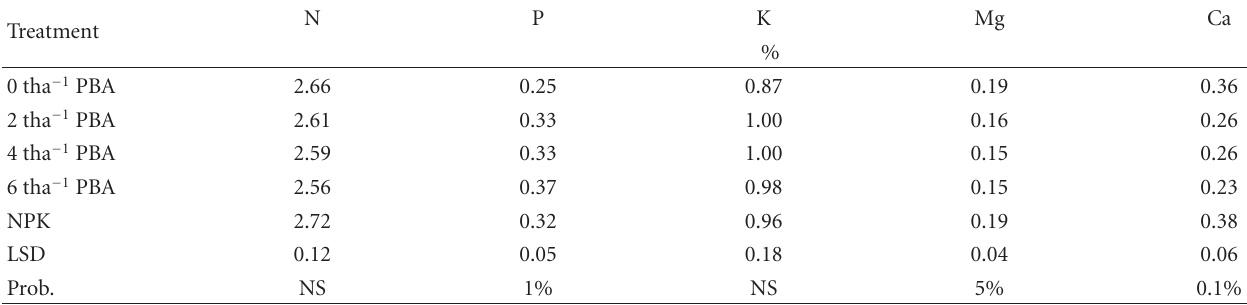
Table 4: E ff ect of palm bunch ash and NPK fertilizer on maize ear leaf nutrient composition for the major rainy season planting. N P K Mg Treatment